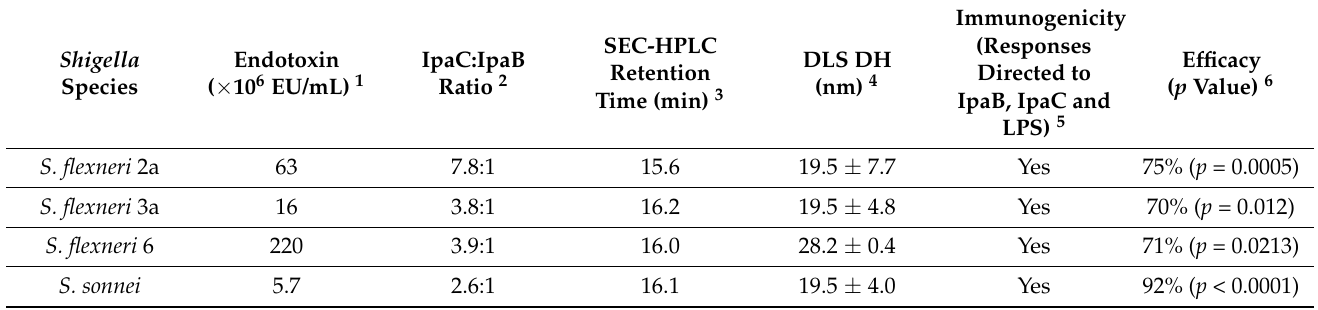
Table 4. Invaplex AR products for the four most globally prevalent Shigella